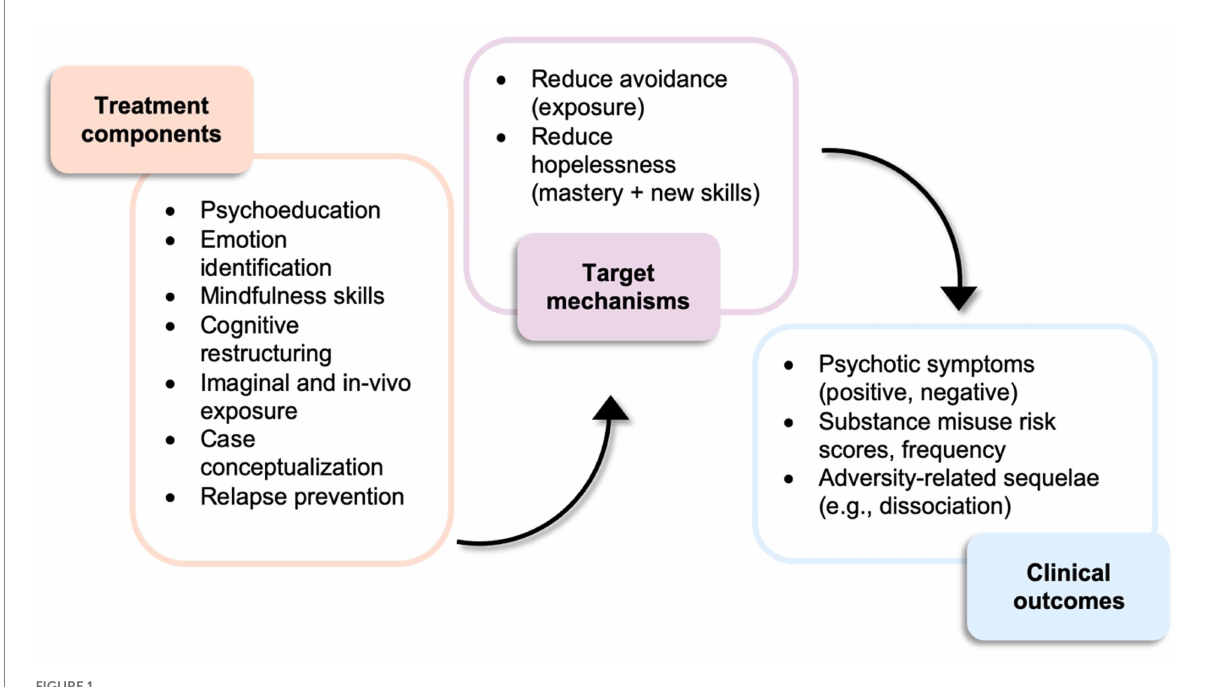
FIGURE 1 PE+ treatment components, target mechanisms, and clinical